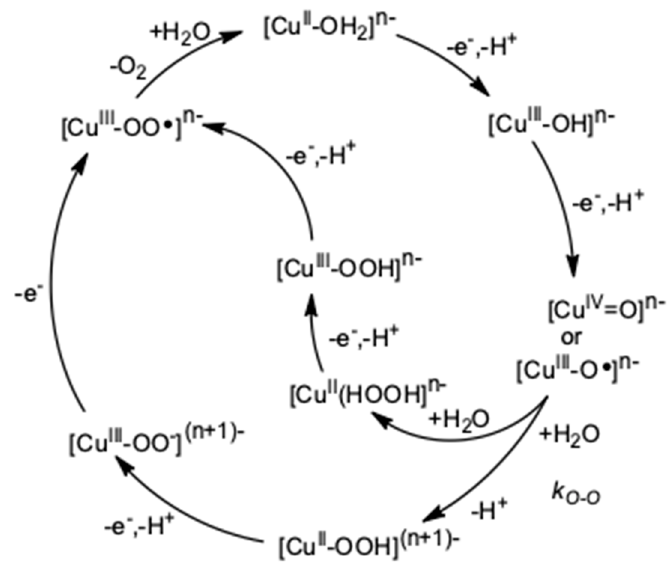
Figure 14. Mechanism proposal typical for the peptide based catalytic systems (ligands omitted for clarity) [41].